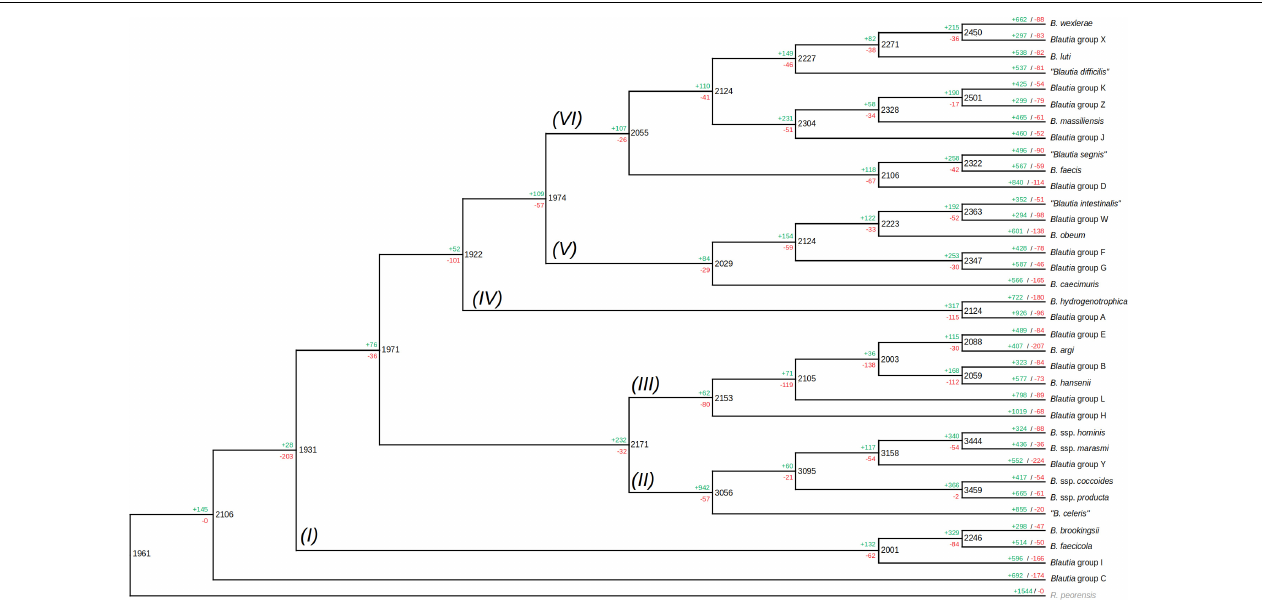
FIGURE 4 | Gain/loss profile among different ancestors and lineages among the representative set of Blautia genomic species. The same tree (with the same members) shown in Figure 1 , was presented as a cladogram, and the data from Count analysis of gene gain/loss models, following Wagner parsimony model for 12,691 gene families, was represented. The roman numbers near each branch represent each proposed lineage among the members. Black numbers represent the number of shared families for a given node (i.e., predicted ancestor), as well as the green and red numbers represent the number of gene families gained and lost for the ancestor. The green and red numbers on the upper side of each terminal branch represented the same terms as before, but for the members of the tree (the terminal nodes). See text for more details.